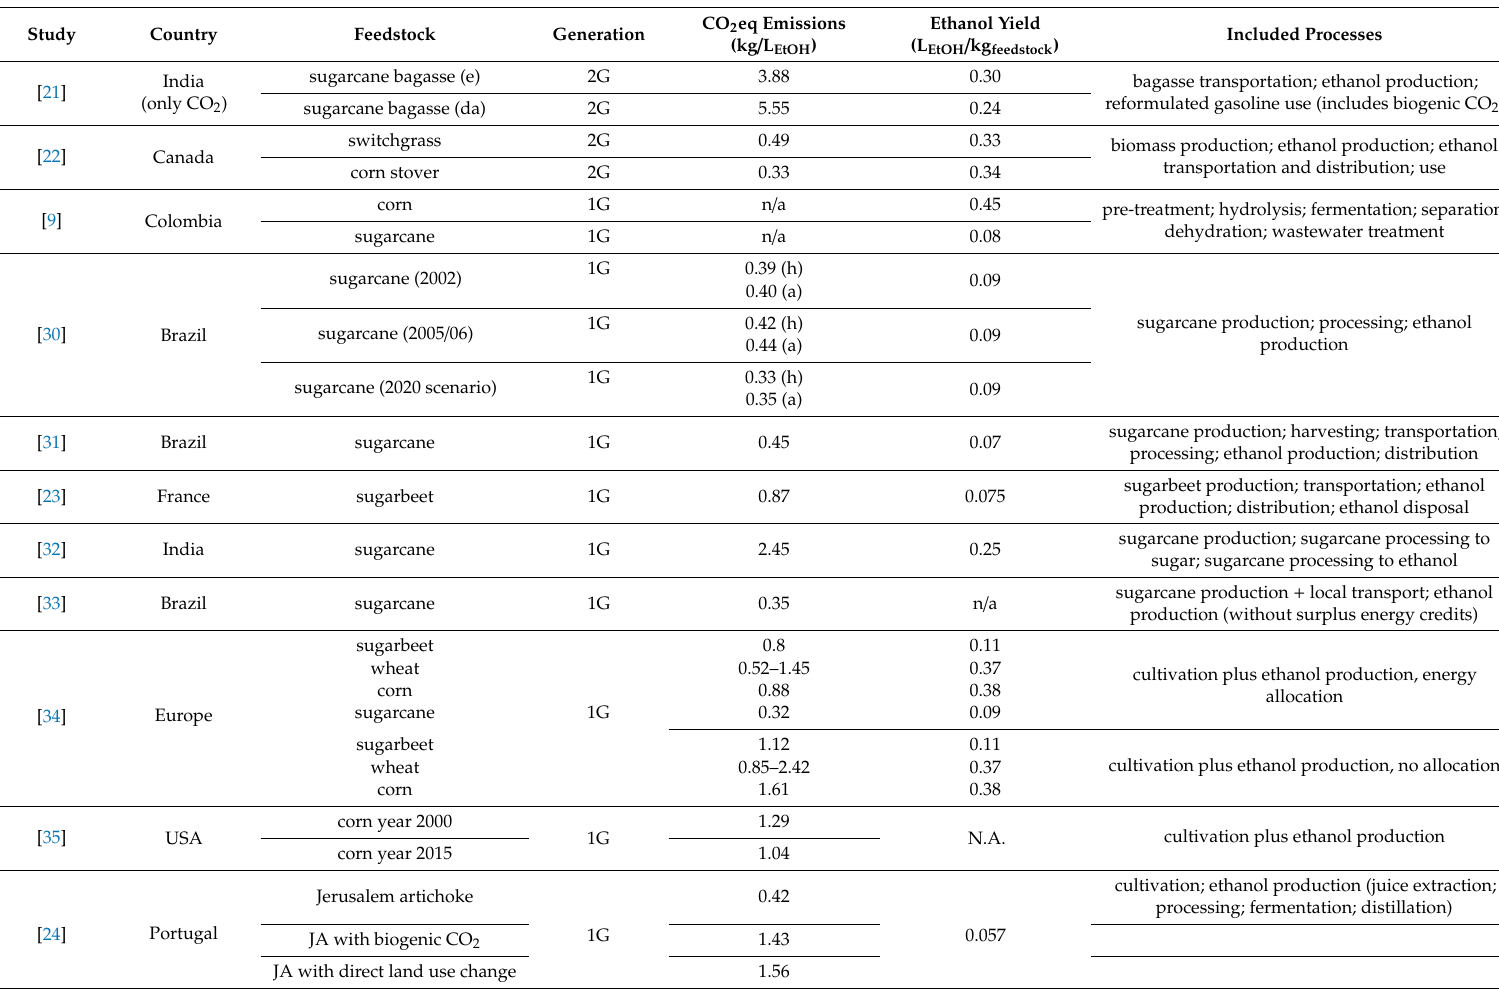
Table 2. Greenhouse gas emissions for the production of bioethanol and yield from di ff erent feedstock. (n / a: not available; e: enzymatic process; da: dilute acid process; h: hydrous ethanol; a: anhydrous